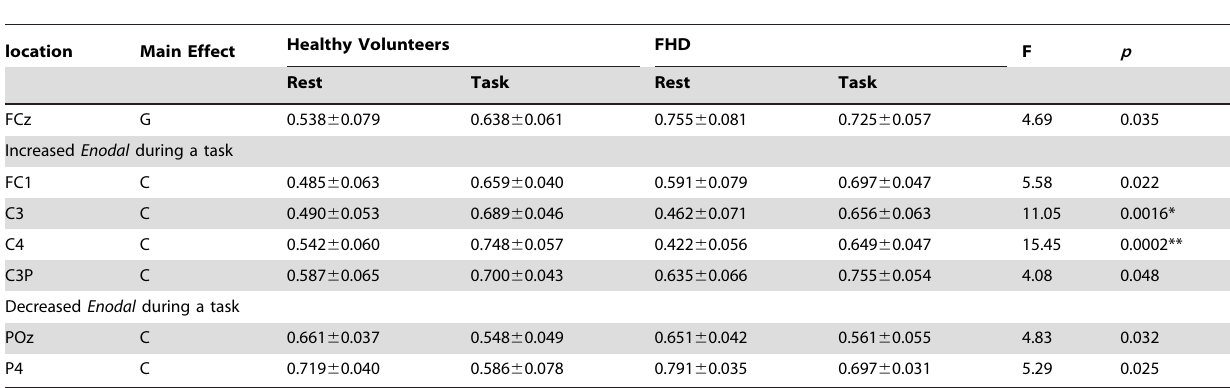
Table 3. Nodes showing significantly different Enodal , at a cost of 0.28 corresponding to the maximal interaction in Eglob .